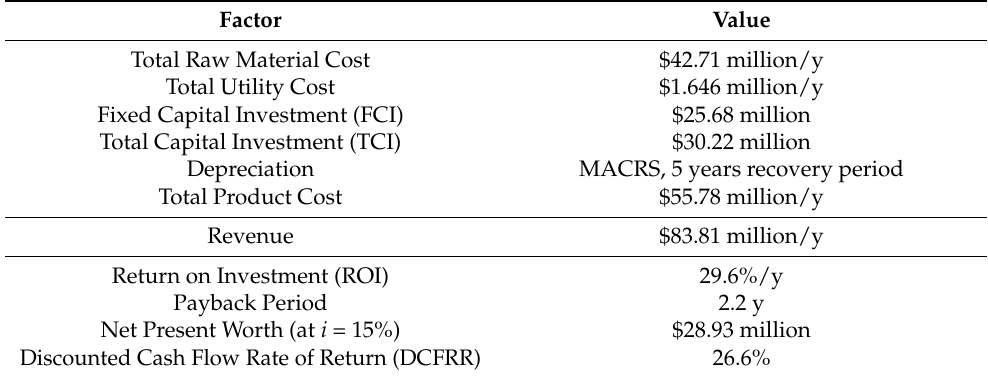
Table 4. The economic performance for the developed MIBK